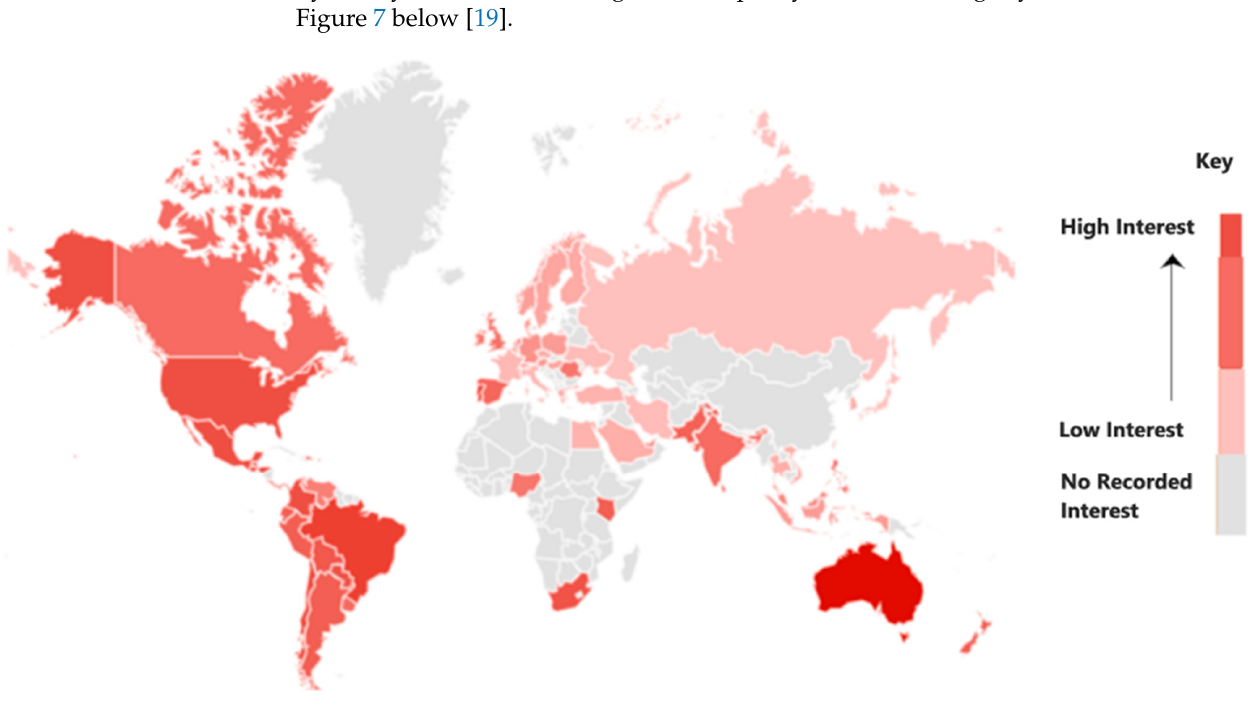
Figure 4. Map illustrating the interest in solar energy over the past 5 years [15].